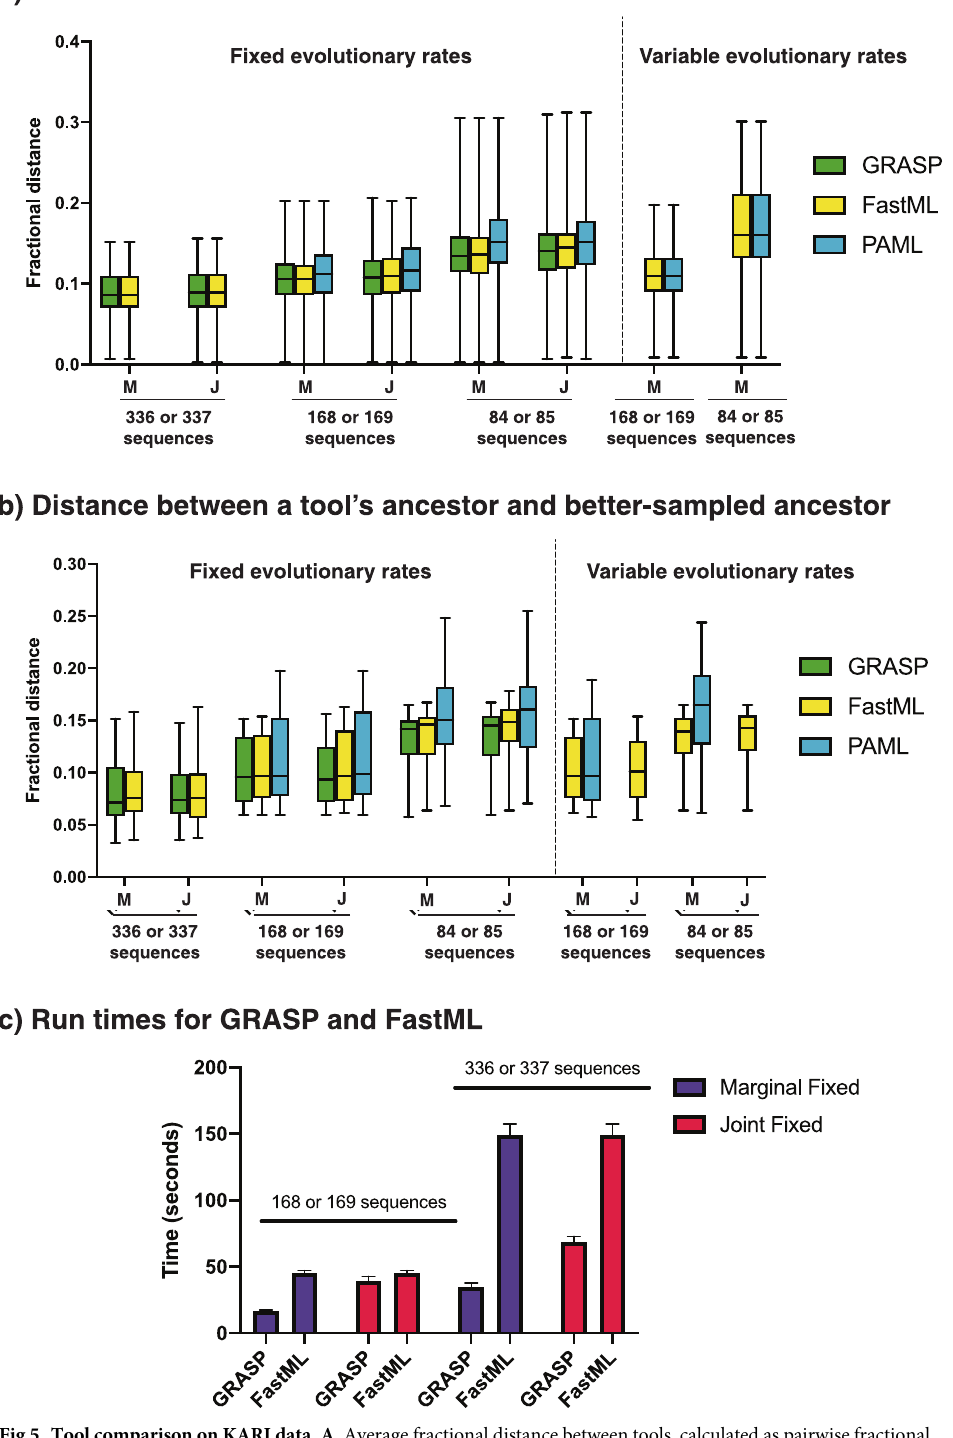
Fig 5. Tool comparison on KARI data. A , Average fractional distance between tools, calculated as pairwise fractional distances for each ancestral prediction for a given tool against all other ancestral predictions of other tools using 5 groups of 336 or 337 sequences, 10 groups of 168 or 169 sequences, or 20 groups of 84 or 85 sequences. Parameter choices are joint (J) vs. marginal (M) reconstruction and fixed vs. variable evolutionary rates (FastML and PAML only). B , Average fractional distance between a better-sampled ancestor inferred by GRASP using 1,682 sequences and each tool / parameter combination at 5, 10, and 20 groups. C , Run times of GRASP and FastML at 5 and 10 groups; PAML was omitted due to long run times. Run times for all tools at 10 and 20 groups are shown in S16 Fig.